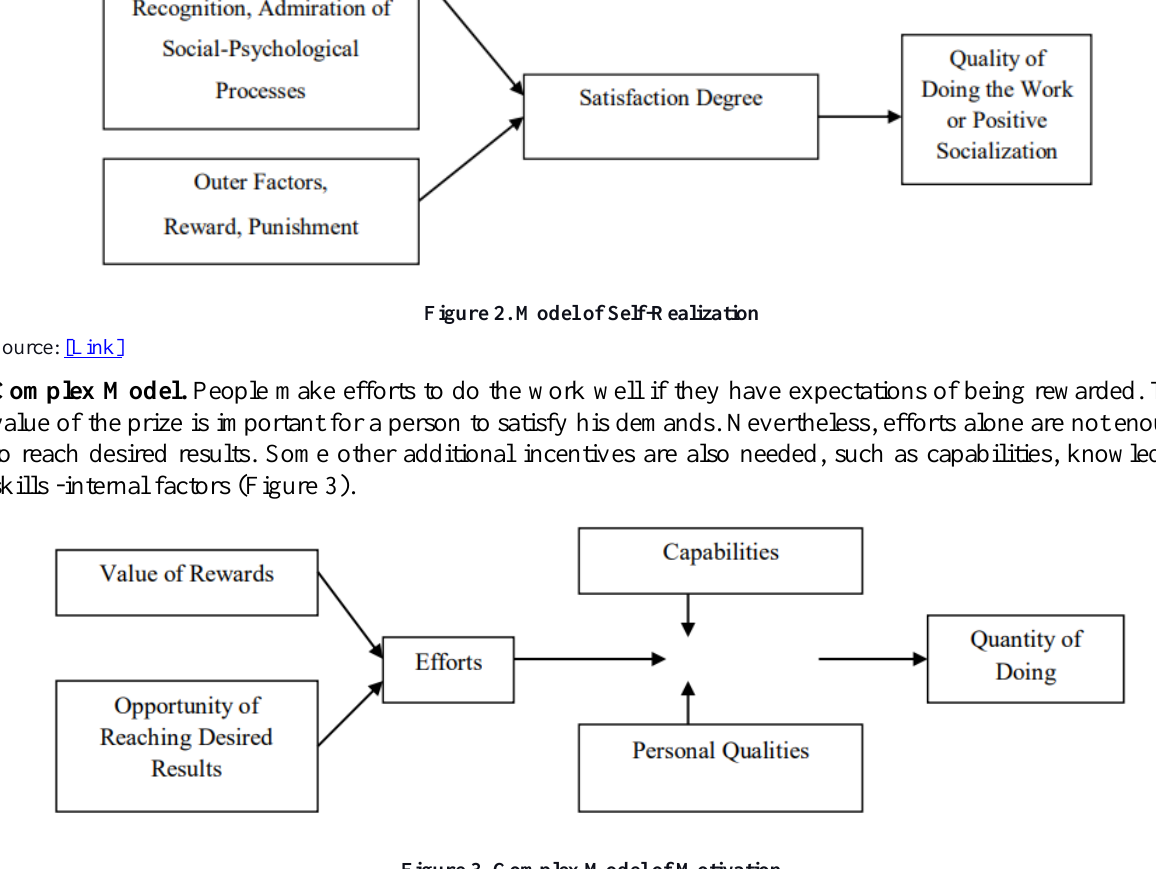
Figure 3. Complex Model of